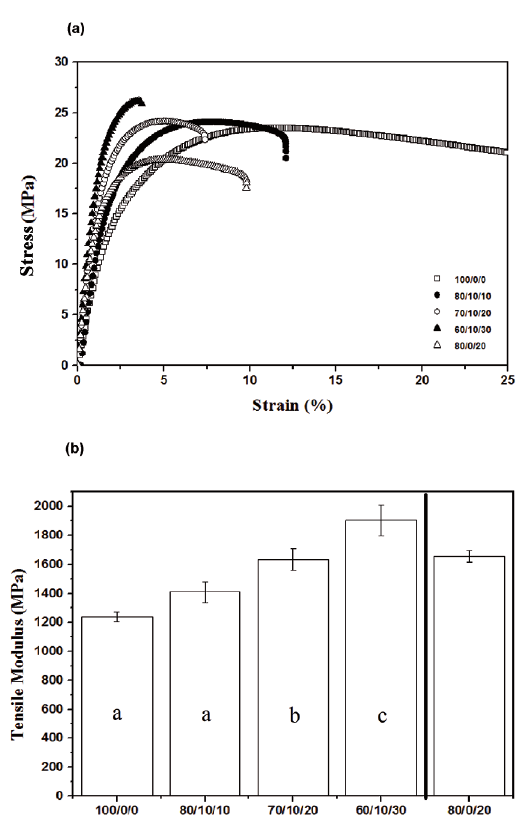
Figure 6: (a) Tensile stress-strain curve and (b) Tensile modulus of the samples.